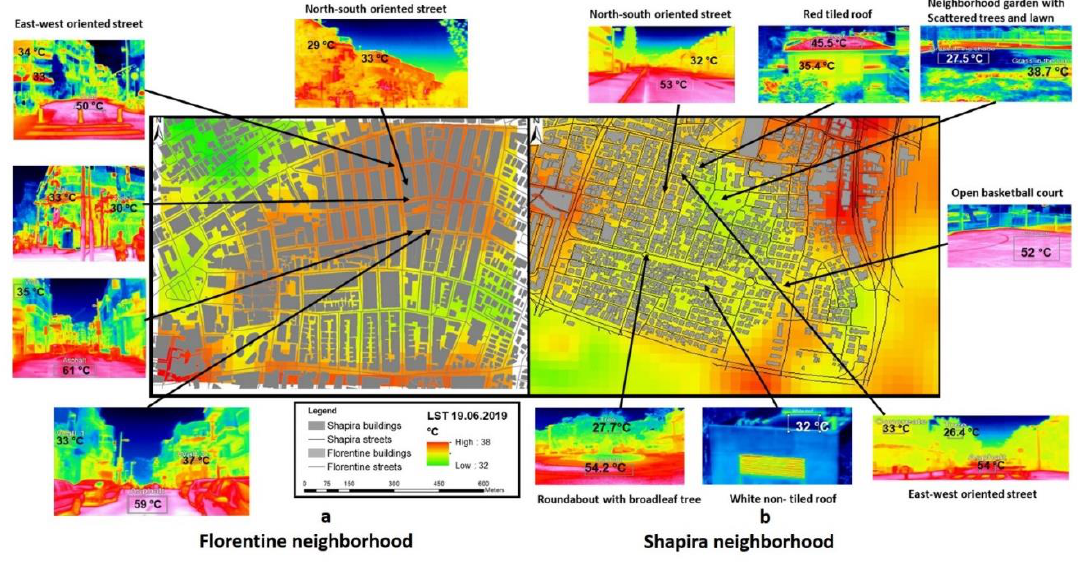
Figure 7. Thermal analysis in the neighborhoods. ( a ) Florentine neighborhood and ( b ) Shapira neighborhood. The base map is a Landsat 8 thermal image from19 June 2019.